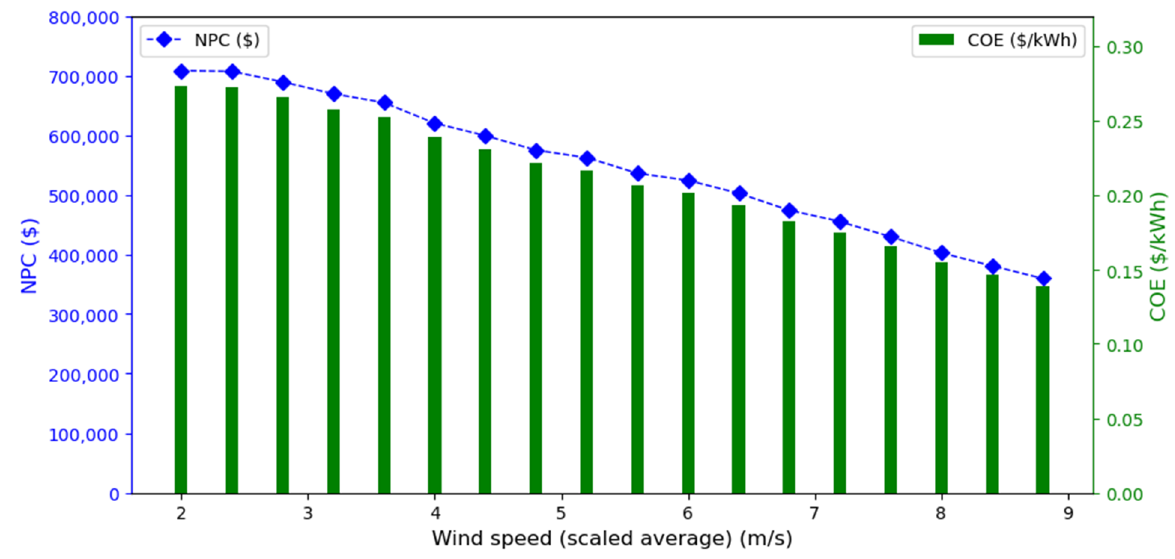
Figure 10. The effect of wind speed variation on the system costs of the Sokoto PV/WT/battery charging scheme.